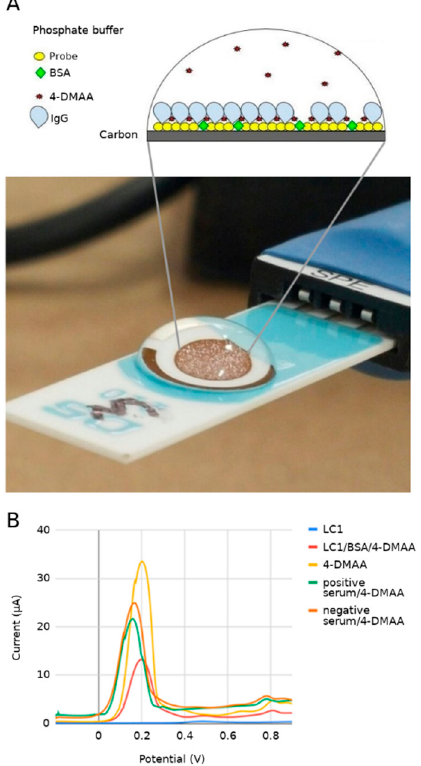
Figure 4. ( A ) Adsorption phases in sequential functionalization steps showing the DPV curves for each component added to the system. ( B ) Peak values for 4-DMAA: 33.50 µ A × 0.20 V, negative serum/4-DMAA: 24.95 µ A × 0.17 V, positive serum/4-DMAA: 21.60 µ A × 0.16 V, LC1/BSA/4-DMAA: 13.25 µ A × 0.19 V, LC1: 1.61 µ A × 0.5 V. Electrolyte: phosphate-buffered saline (pH 7.4).